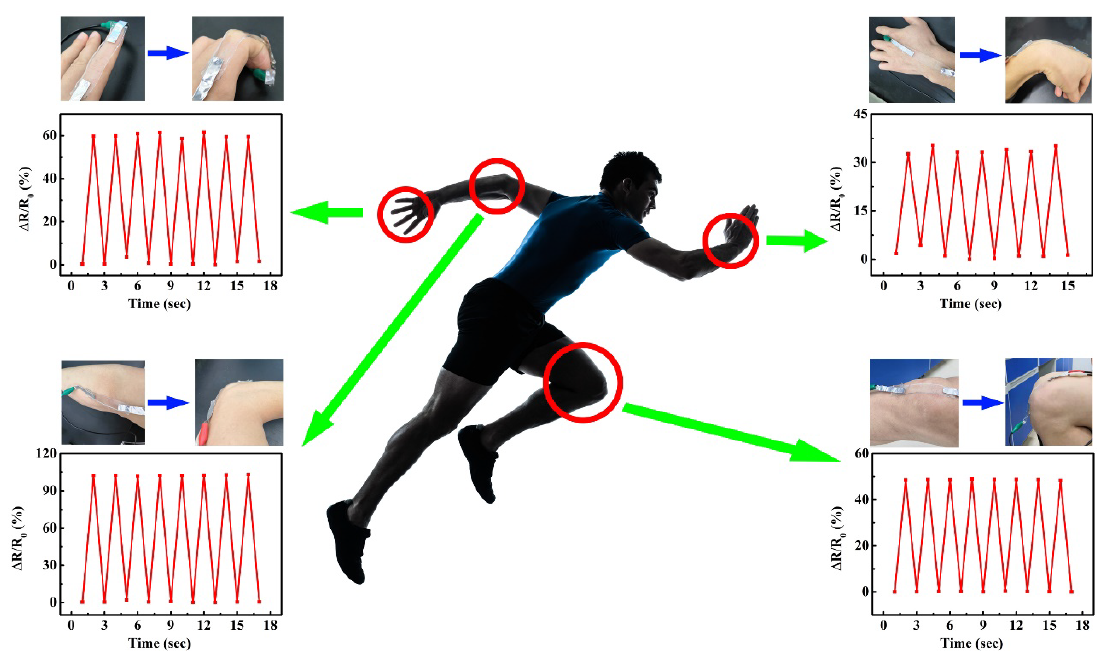
Figure 7. Applications of the LiCl/p(HEAA − co − BD) hydrogel for monitoring human motion.